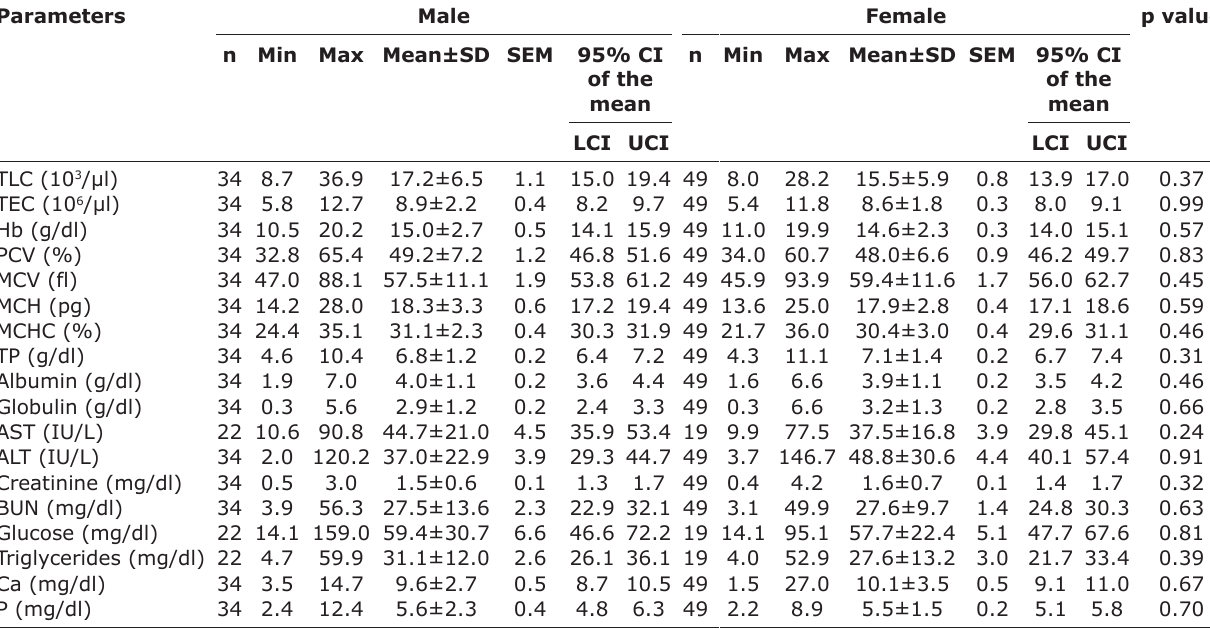
Table-2: Comparison of hematology and serum biochemistry results for male and female Indian leopards ( Panthera pardus fusca ) from BBP and MLRC.